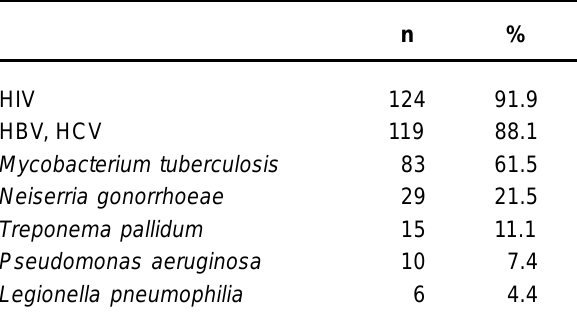
TABLE 6- Infectious agents considered important by the